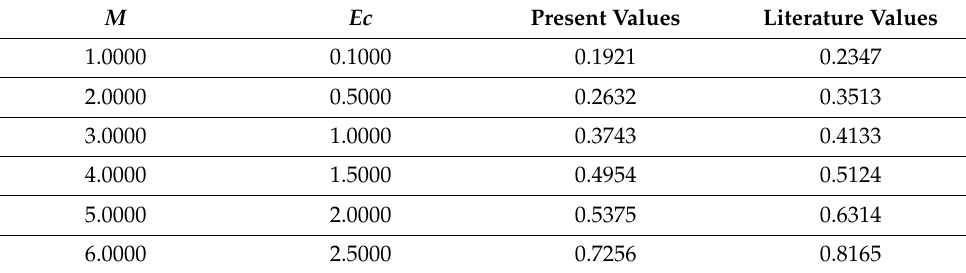
Table 8. Comparison of the present Nusselt number with the